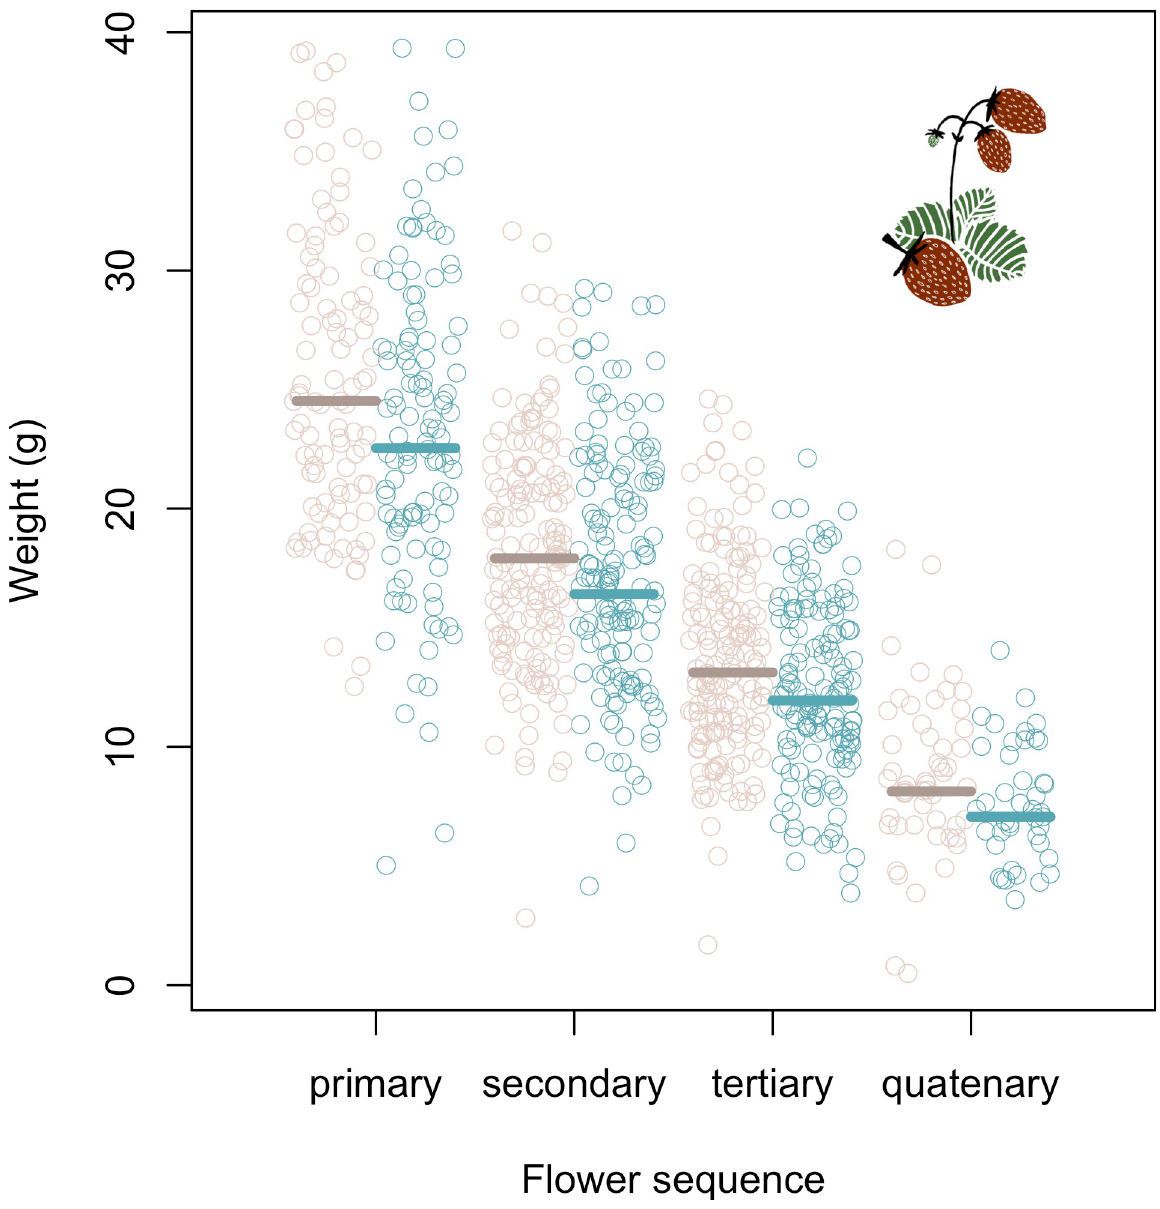
Fig 3. Strawberries weighed less in cages where the bees had been exposed to clothianidin via seed-coated rapeseed. Circles show raw data and lines show back-transformed posterior means from the model for control (beige circles, brown lines) and clothianidin (turquoise circles and lines) cages. Weight is shown separately for strawberries from each of the four flower